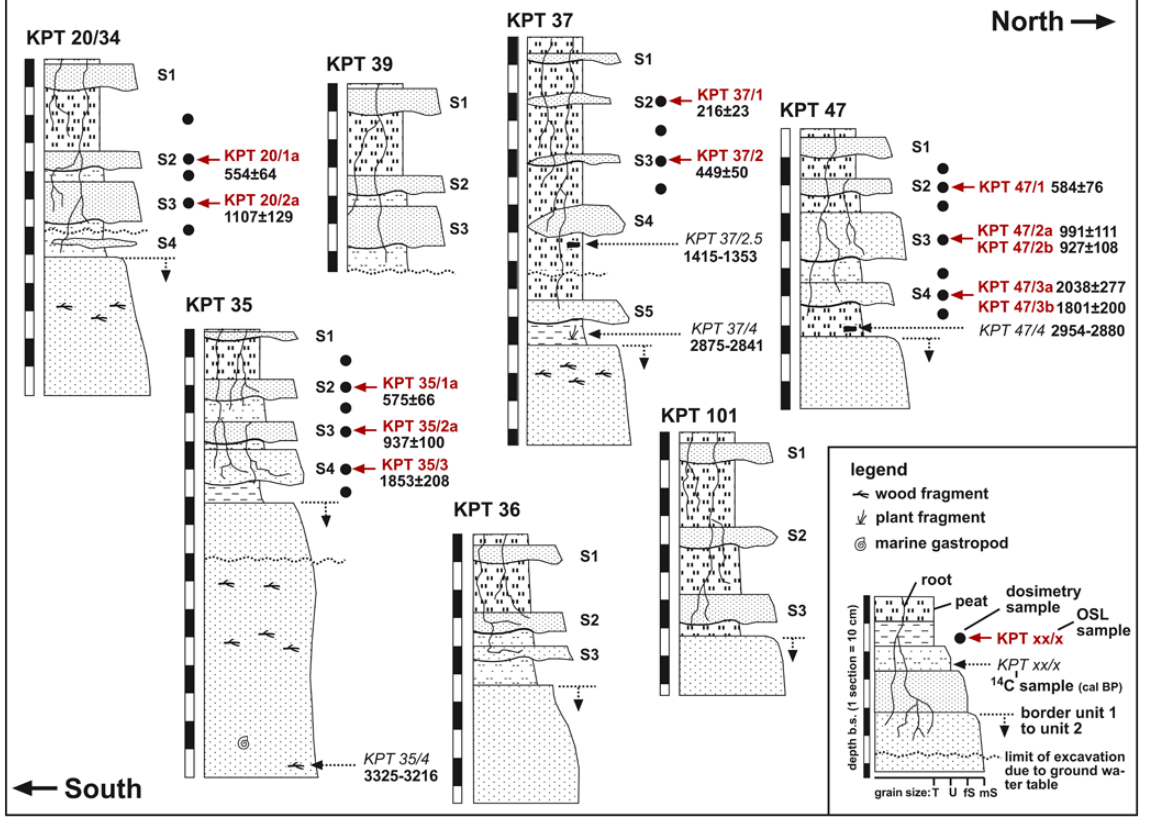
Fig. 3. Stratigraphy and chronology of all documented